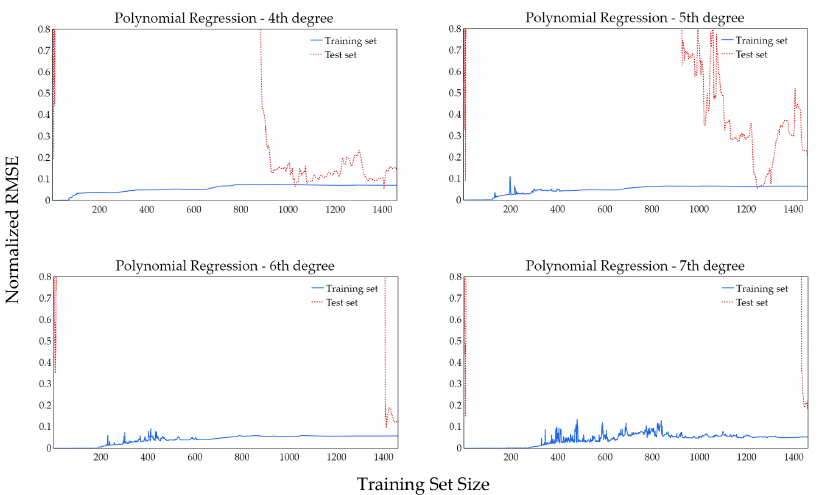
Figure 9. Multiple degrees of polynomial regression learning curves for 1st DCT frequency